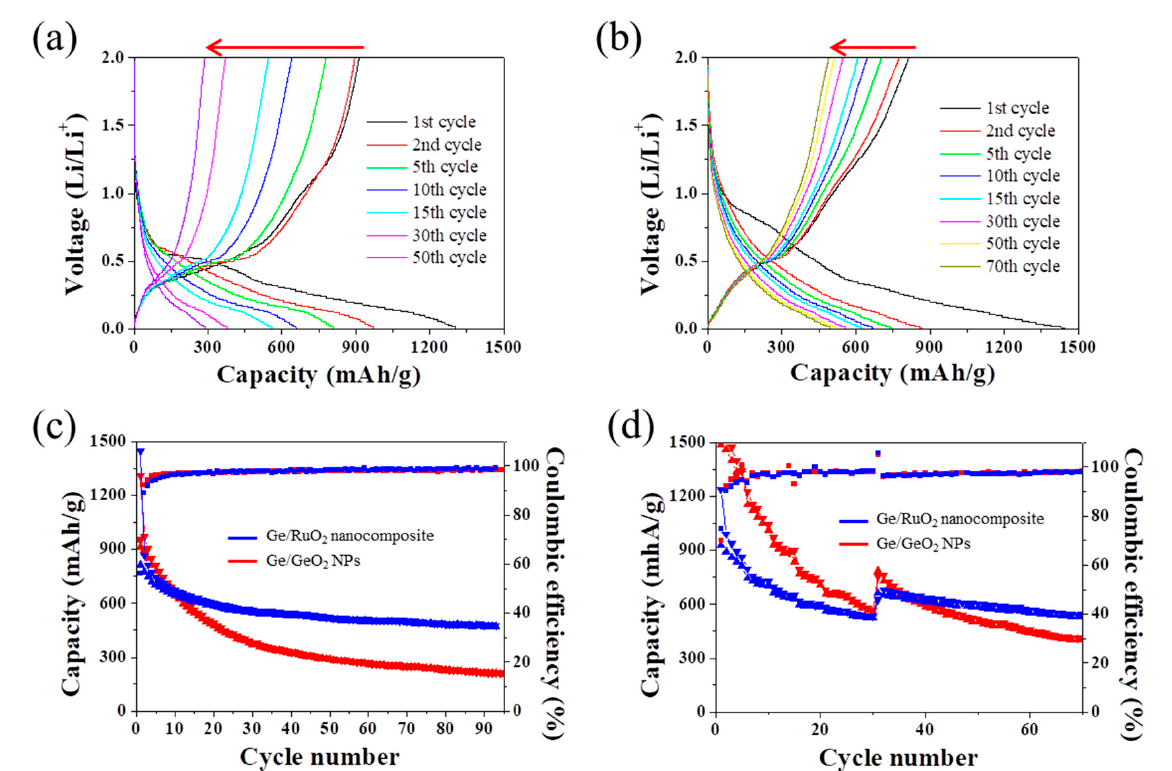
Figure 5. Electrochemical charge/discharge profile of ( a ) Ge/GeO 2 NPs and ( b ) Ge/RuO 2 nanocom- posite at a current density of 100 mA g − 1 (The red arrows indicate a decrease in capacity by cycling). Capacity and coulombic efficiency of Ge/GeO 2 NPs and Ge/RuO 2 nanocomposite ( c ) at a current density of 100 mA g − 1 and ( d ) at various current densities from 0.1 mA g − 1 to 1.0 mA g − 1 .